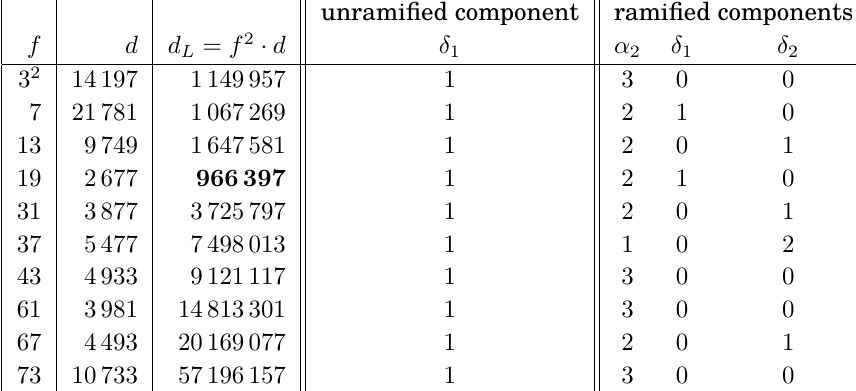
Table 29: Heterogeneous quartets of S 3 -fields with splitting prime (power) f